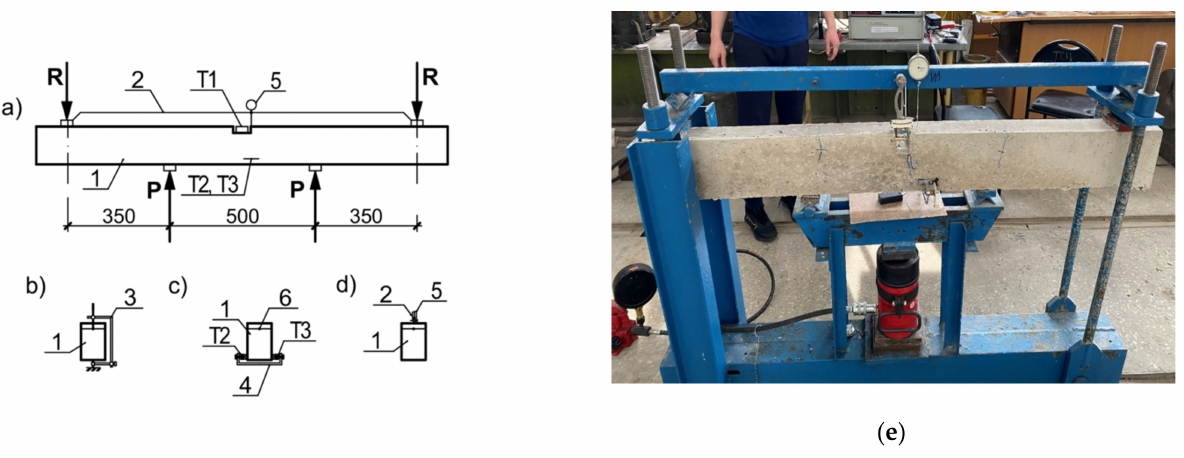
Figure 4. Beam testing scheme. ( a ) load and device placing; ( b ) strain gauges T1 fixing; ( c ) strain gauges T2, T3 fixing; ( d ) deflection indicator fixing; 1—beam; 2—deflection measurement traverse; 3, 4—strain gauges T2, T3 fixing; 5, 6— deflection indicator; ( e ) beam testing